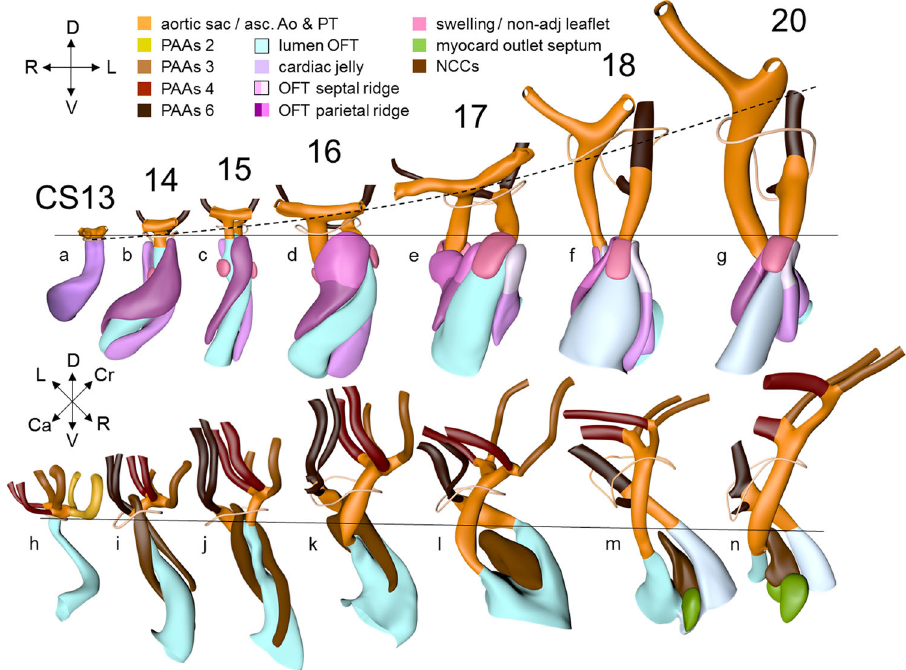
Fig. 7 Pictorial timeline of the changes in size and shape of the lumen, endocardial ridges and swellings, and neural crest prongs of the out fl ow tract. The images are aligned on the location of the developing pulmonary valve (black line). Panels a – g show cranial views of the out fl ow-tract lumen fl anked by the parietal and septal endocardial ridges, and aortic and pulmonary swellings. The viewing angle is the same as for Fig. 6d. The arterial trunks are shown for identi fi cation of the subaortic and subpulmonary channels. The ascending aorta is recognizable by its lateral horns. The widening of the distal portions of both out fl ow ridges during CS16 and CS17 presages their allocation to the right or left semilunar lea fl ets of the aortic and pulmonary arterial valves at CS18. The valvar portions are marked by a less dark tint of the coding color, and are con fi ned to the distal portion of the myocardial out fl ow tract. The dashed black line in panels a – g show the axial growth of the intrapericardial component of the aortic trunks. The saddle-shaped wire loop shows the position of the pericardial re fl ection. Panels h – n show the lumen of the out fl ow tract as seen from the right side, showing the neural crest cells within the aortopulmonary septum extending as columns of dense mesenchyme into both endocardial out fl ow ridges. The fusion of these columns creates a temporary “ whorl ” of neural crest cells between the subaortic and subpulmonary channels. The neural crest cells largely disappear between CS18 and CS23 due to intense apoptosis 166 , with invading cardiomyocytes simultaneously populating the shell of the septum 75,213 . All images are also available as preset views in the corresponding